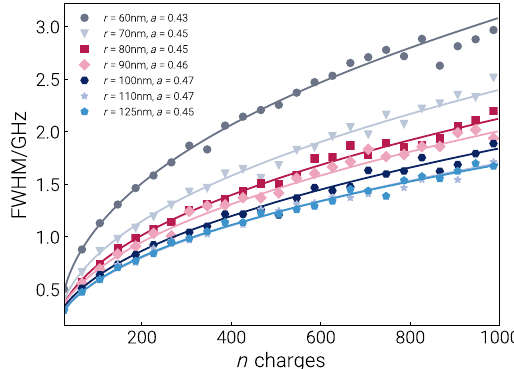
FIG. 11. Effect of surface charges on inhomogeneous line- width. Inhomogeneous broadening due to surface charges for different pillar radii. The lines represent a fit with the power law f ð x Þ ¼ b ð x − x 0 Þ a . The power law noticeably differs from the power law found for bulk charges [Fig. 10(a)].